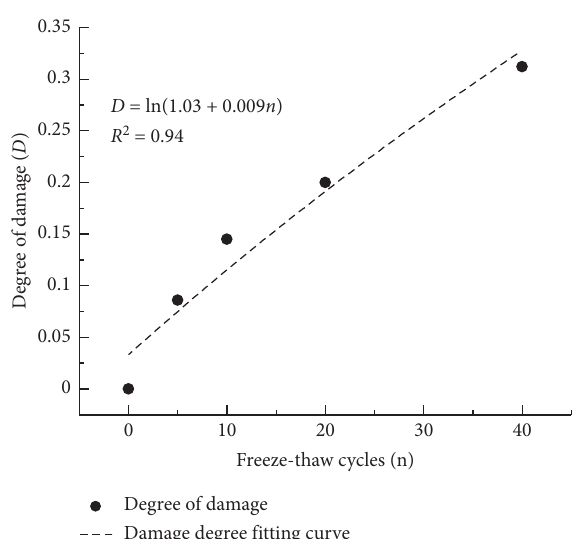
Figure 12: Yellow sandstone damage curve under freezing and thawing.